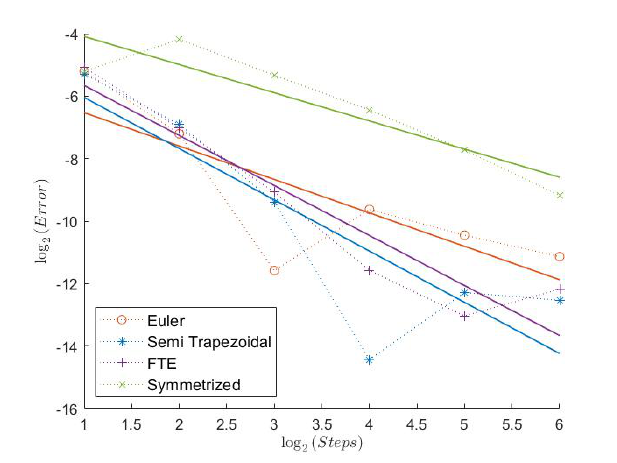
Figure 17. Indicator Model 3.